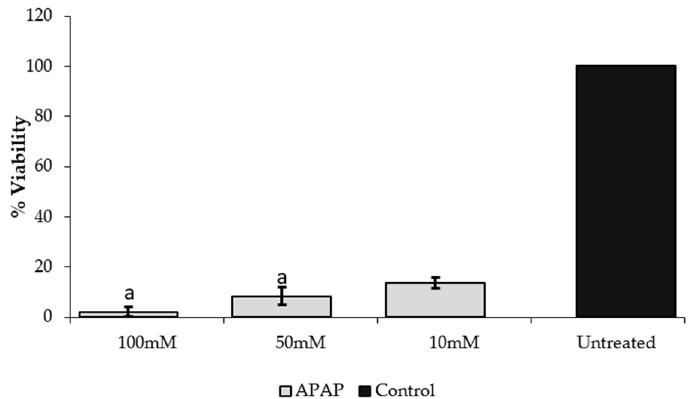
Figure 2. Cytotoxic effect of APAP on HepG2 cells after 24 h treatment. Values are means ± SD percentage of control from three replicates of independent experiments. Bars with the same letters are not significantly different ( 𝑃 < 0.05). APAP: Acetaminophen.